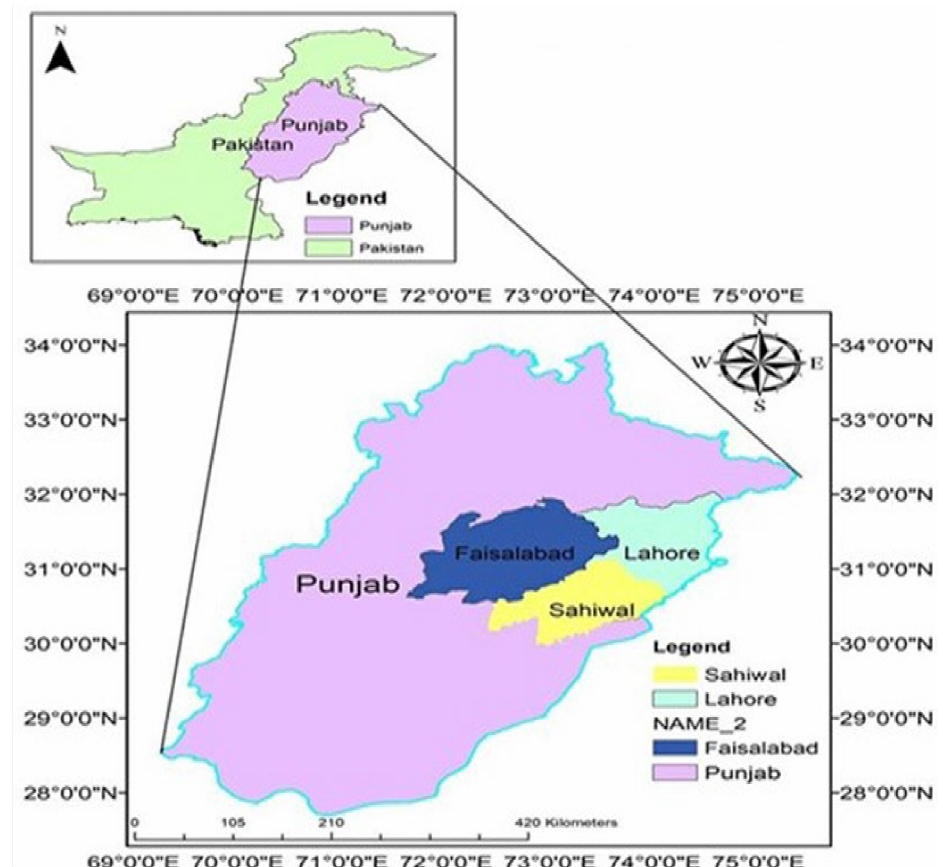
Figure 1. Location maps of